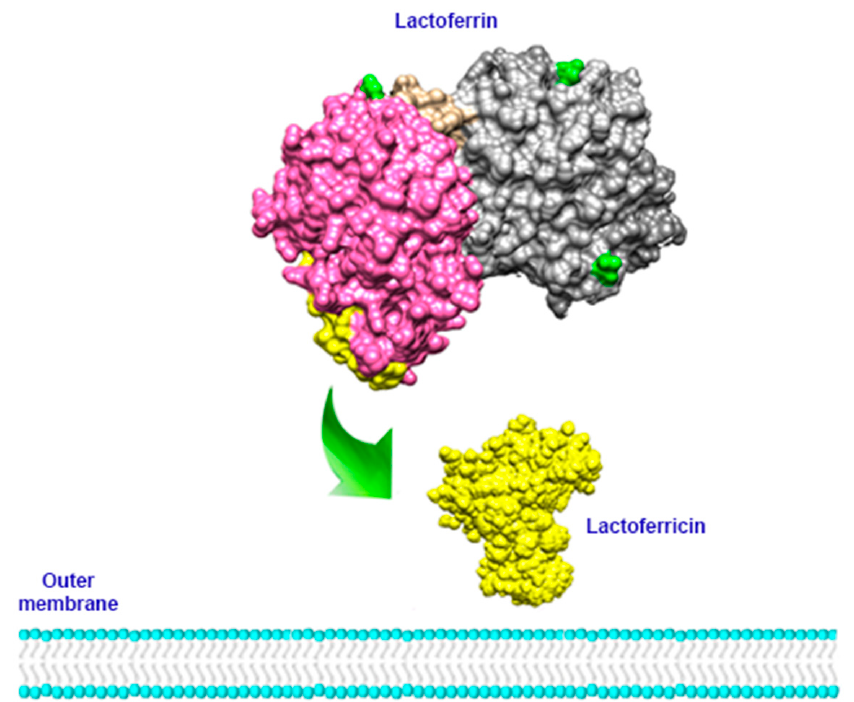
Figure 3. Schematic representation of Lfcin binding with LPS. When Lfcin (yellow) is released from Lf, it can bind to bacterial LPS, activate the immune response, and disrupt the bacterial outer membrane.